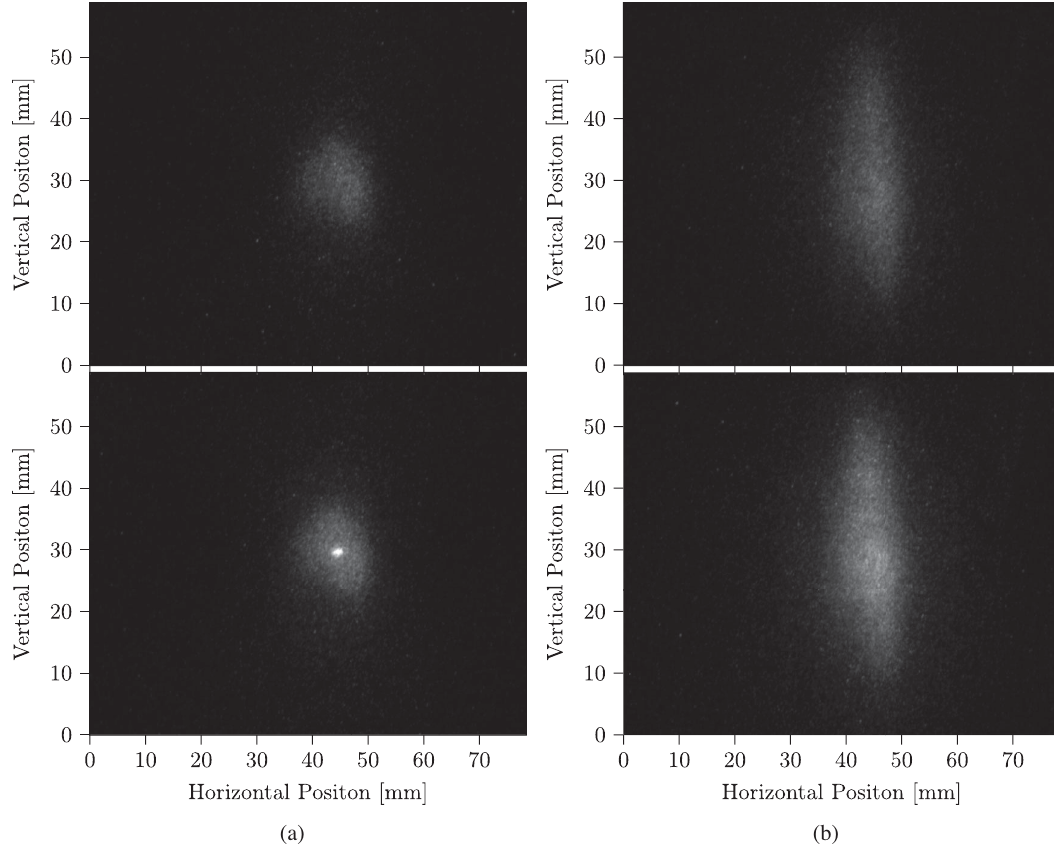
FIG. 17. (a) Image with a 70 μ s gate (top) and 100 μ s (bottom) from the beginning of the macropulse for 400 μ A current for target incidence ψ ¼ 25 °. (b) Image with a 70 μ s gate (top) and 100 μ s (bottom) from the beginning of the macropulse for 400 μ A current for a target incidence of ψ ¼ 65